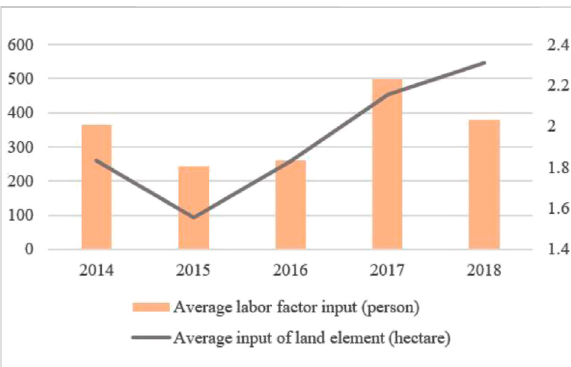
FIGURE 5 Average value of labor factor and land factor input of high- tech industrial enterprises in Zhejiang province in 2018.